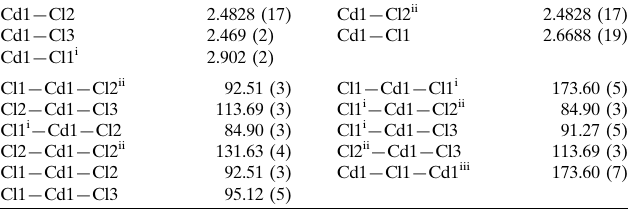
Selected geometric parameters (A˚ , (cid:4) ).